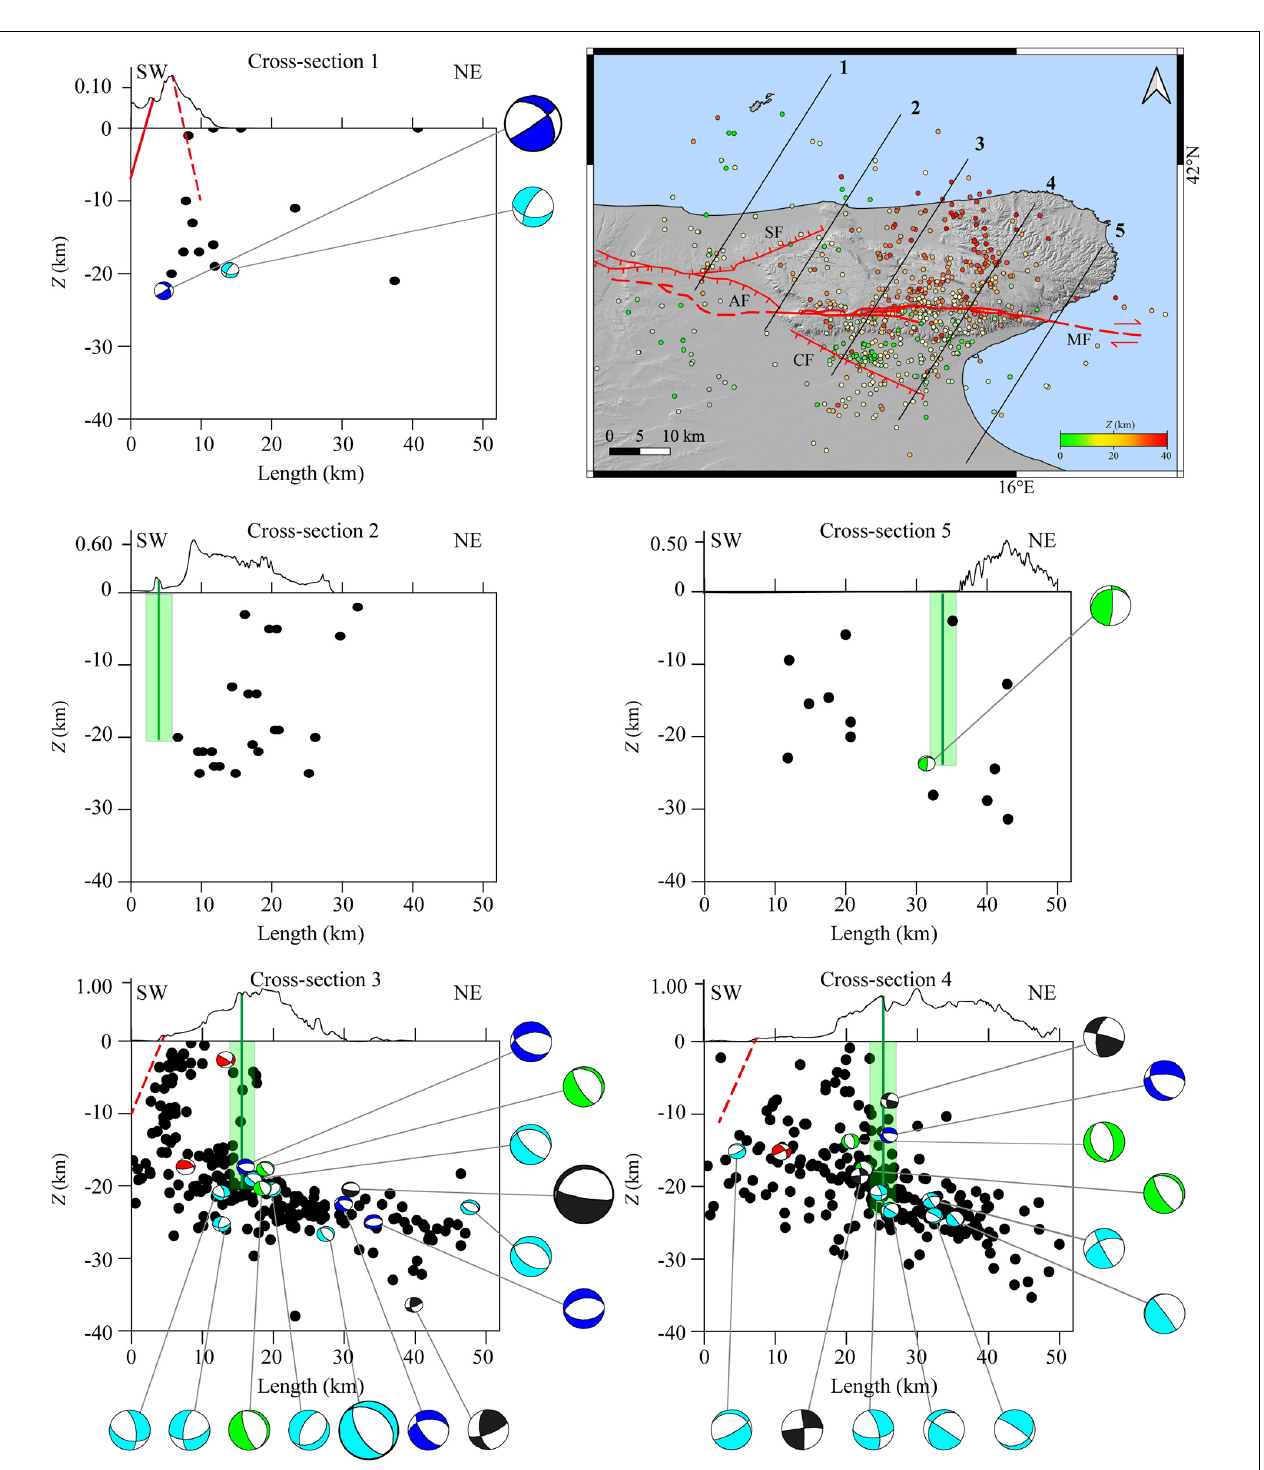
FIGURE 7 | (Top-right) SW-NE vertical cross-sections reported as numbered black lines in the geographical map; epicenters are colored according to the color scale bar. All cross-sections have 52 km length and 8 km semi-width per side. Hypocenters are plotted as black circles in the vertical cross-section maps. Above each cross-section, the topographic profile is reported. In each cross-section map, the focal mechanisms are projected in cross-section. Beachball colors are described in Figure 5 caption. Focal mechanisms dimensions are scaled according to magnitude ranges (small for Ml < 3; big for Ml ≥ 3). Green line represents the MF trace reported in depth. The surrounding area highlighted in light green represents the rock volumes involved in the MF shear zone. Red lines are for the Apricena AF, the Candelaro CF, and the Sannicandro SF Faults, dashed lines indicate that no information is available for the fault dip and/or for the fault depth.